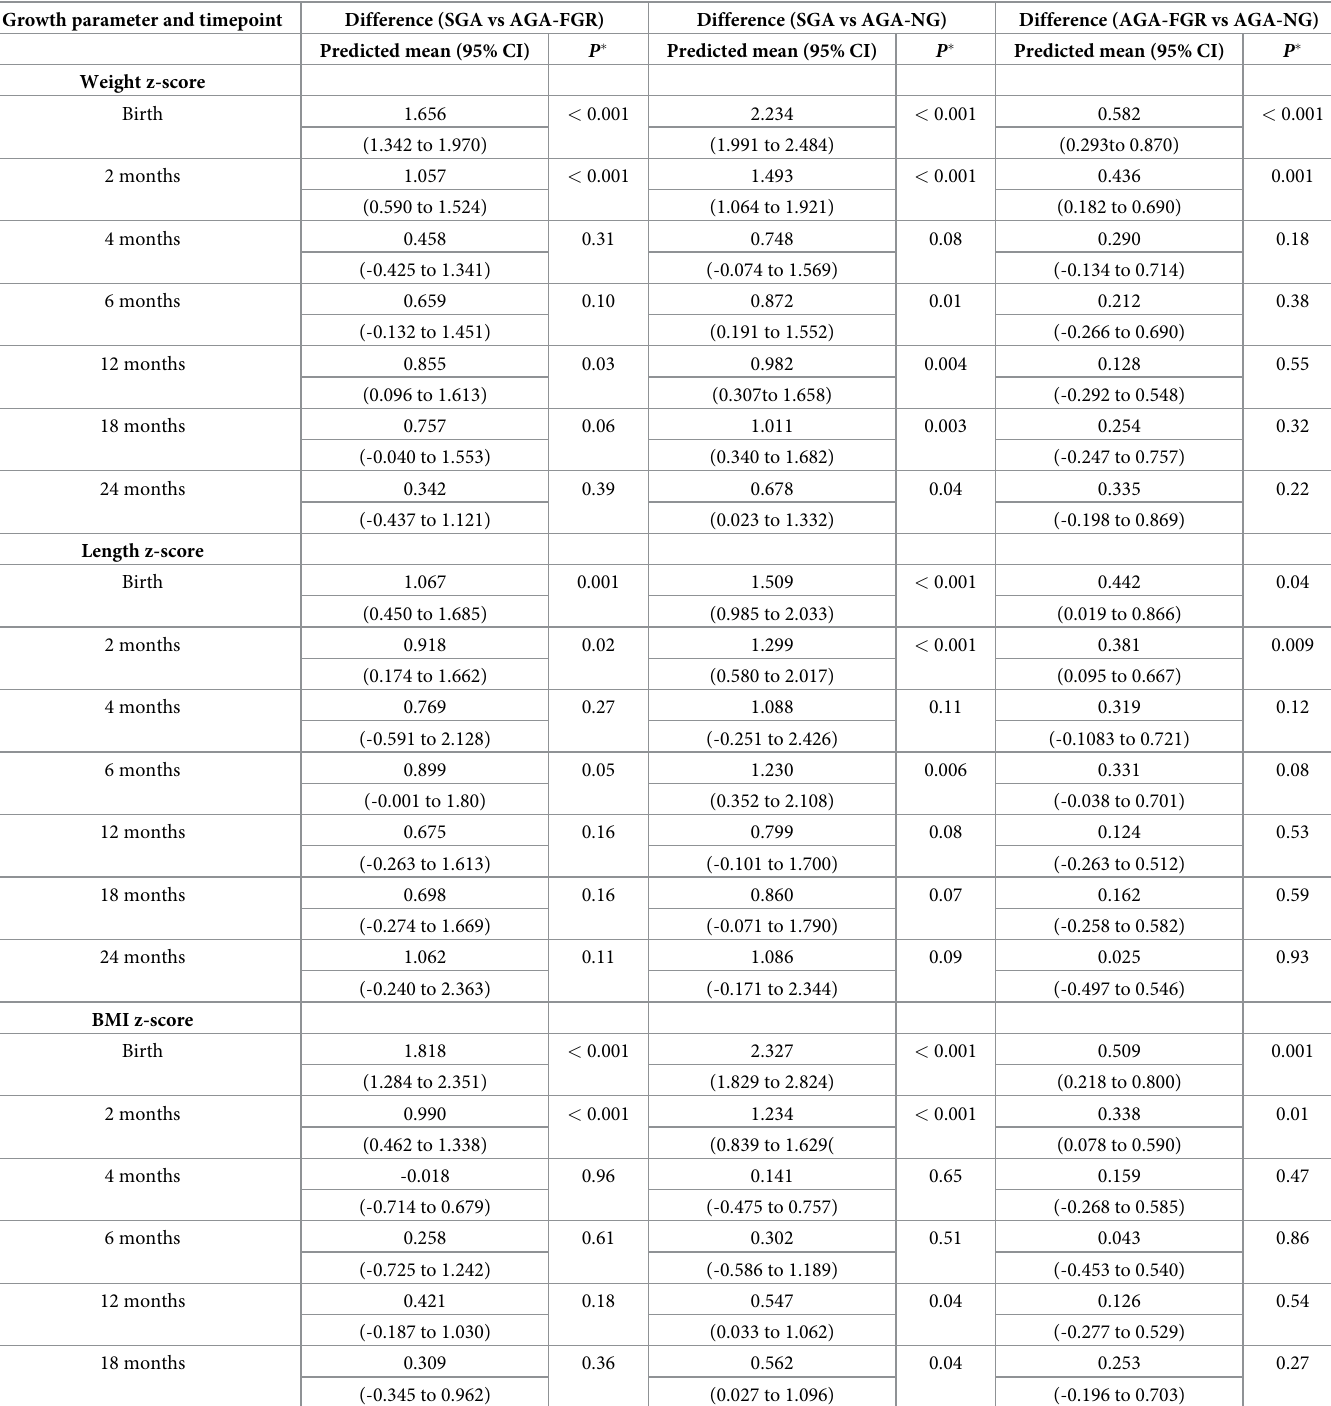
Table 2. Comparison of predicted mean growth parameter z-scores between SGA, AGA-FGR and AGA-NG infants. Growth parameter and